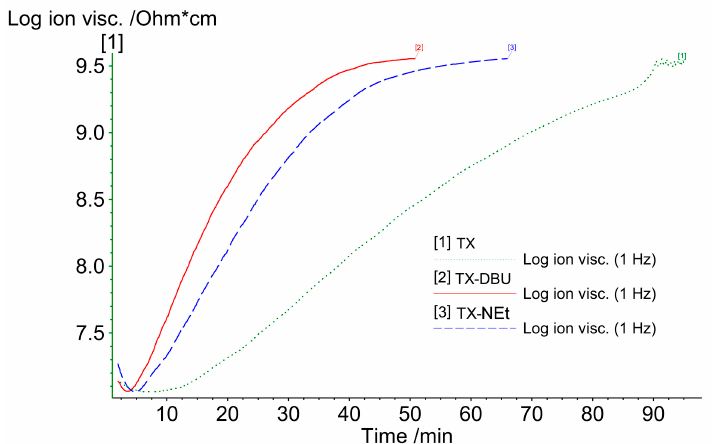
Figure 7. Dielectric analysis curves for photocuring initiated by the PBGs.